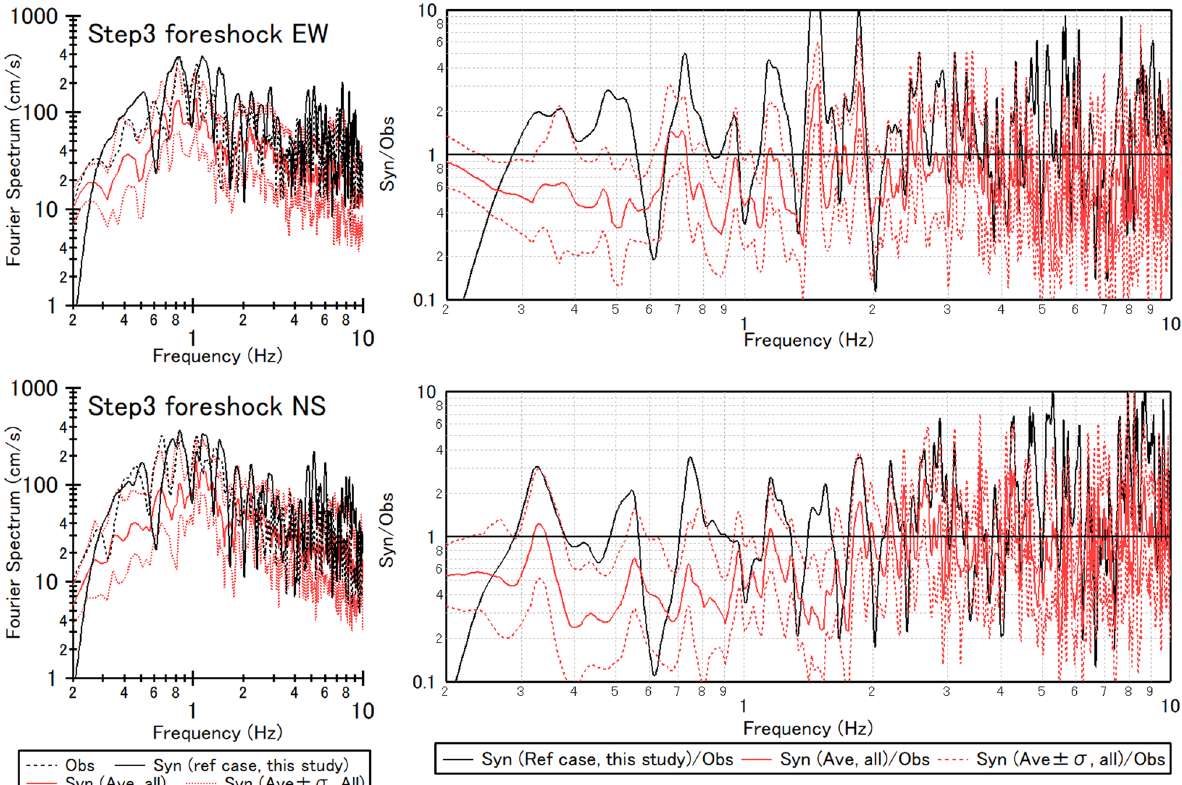
Fig. 16 Comparisons of the predictions in this study and those by other blind prediction participants for the earthquake of 2016/04/14 21:26 ( M w 6.1). (Left) Black dashed and solid lines indicate the observed spectra and the synthetic spectra of the reference case (Table 2) in this study, respectively. Red solid and dashed lines indicate the average and average σ spectra of all participants, respectively. (Right) Black and red lines ± indicate the ratios of the lines of same type in the left panel to the observed